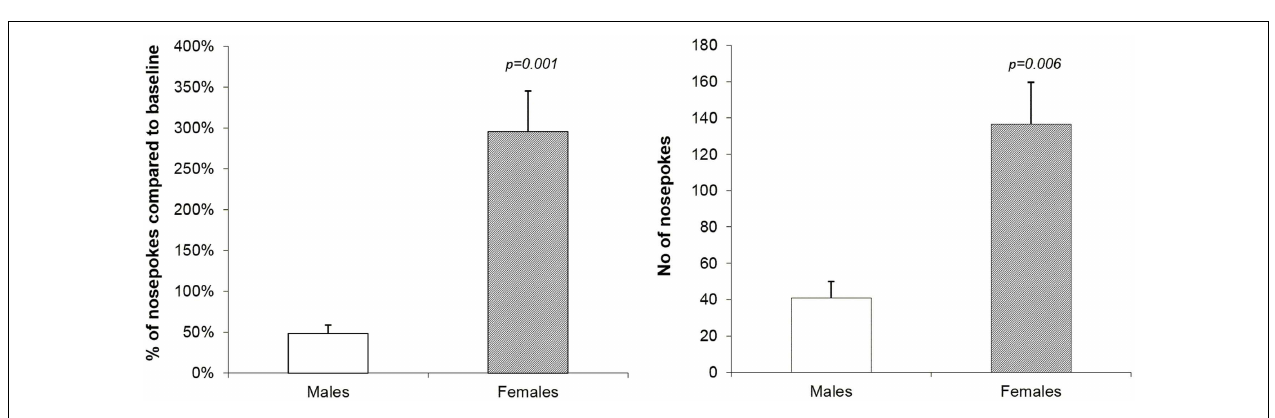
FIGURE 3 | Reinstatement of methamphetamine seeking behavior in male and female rats . The graphs show a percent of mean basal nose-poking (14days of acquisition and maintenance) and number of nose-pokes in the reinstatement session in male and female rats. There was a statistically significant difference between the sexes in both measures: